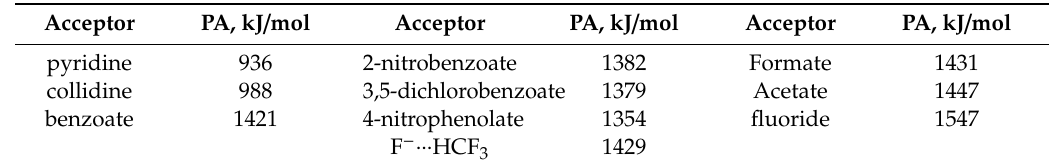
Table 4. Gas-phase proton a ffi nities of selected proton acceptors.